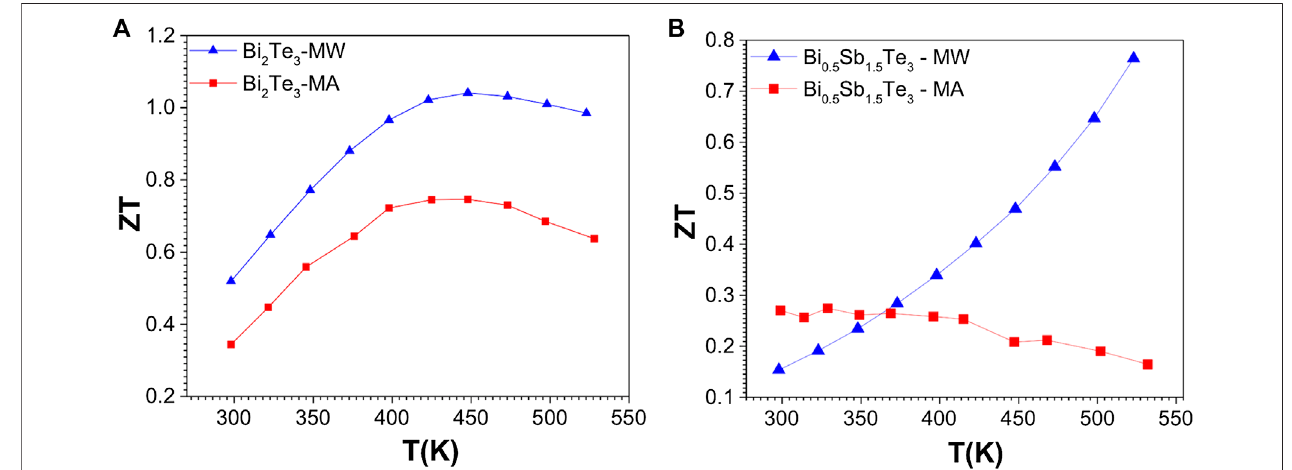
FIGURE 8 | Temperature-dependent TE fi gure of merit, ZT , of (A) MW-Bi 2 Te 3 and MA-Bi 2 Te 3 , and (B) MW-Bi o.5 Sb 1.5 Te 3 and MA-Bi o.5 Sb 1.5 Te 3 samples.